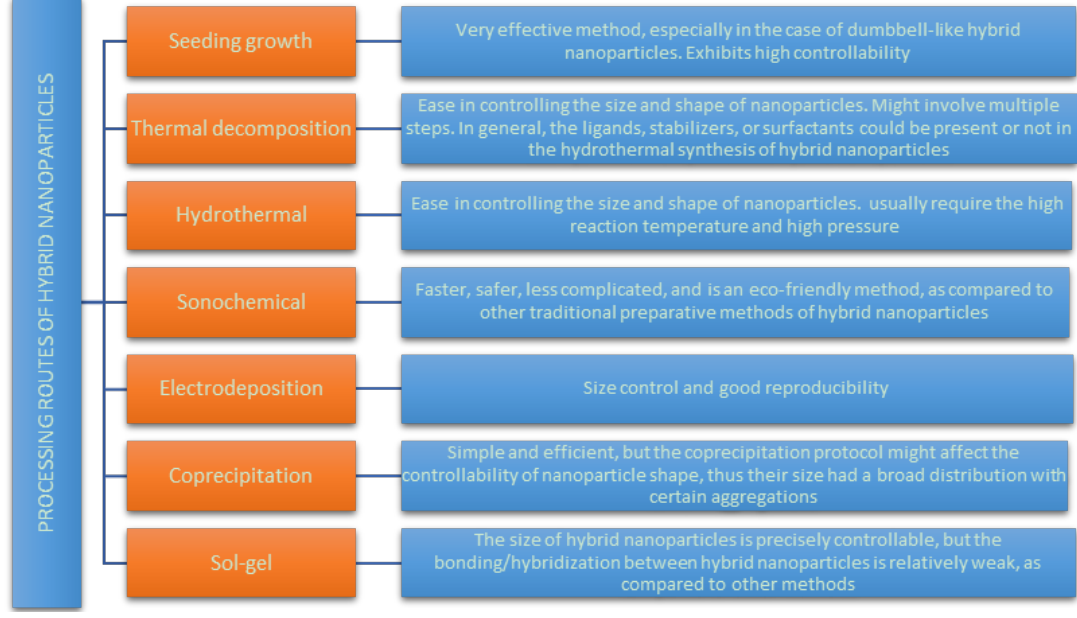
Figure 4. Processing routes, with their main characteristics, used to fabricate hybrid nanoparticles by chemical methods.